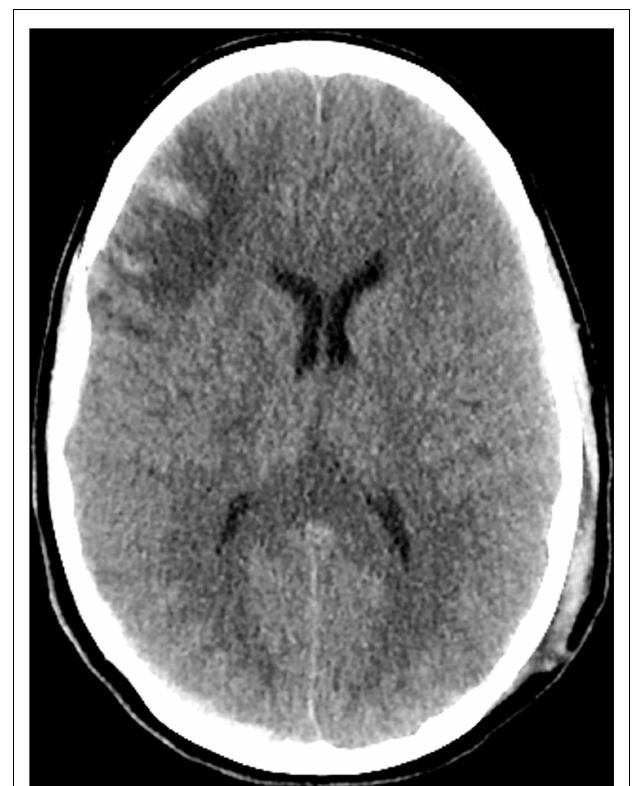
FIGURE 1 | CT scan of the head on hospital day 1 demonstrates poor gray-white junction differentiation suggestive of diffuse cerebral edema. There are scattered areas of subarachnoid hemorrhage in multiple frontal and parietal sulci as well as scattered areas of hyperattenuation at the gray-white junction in the frontal and parietal lobes which may be related to contusions or diffuse axonal injury. Also seen is a large left parietal scalp hematoma.